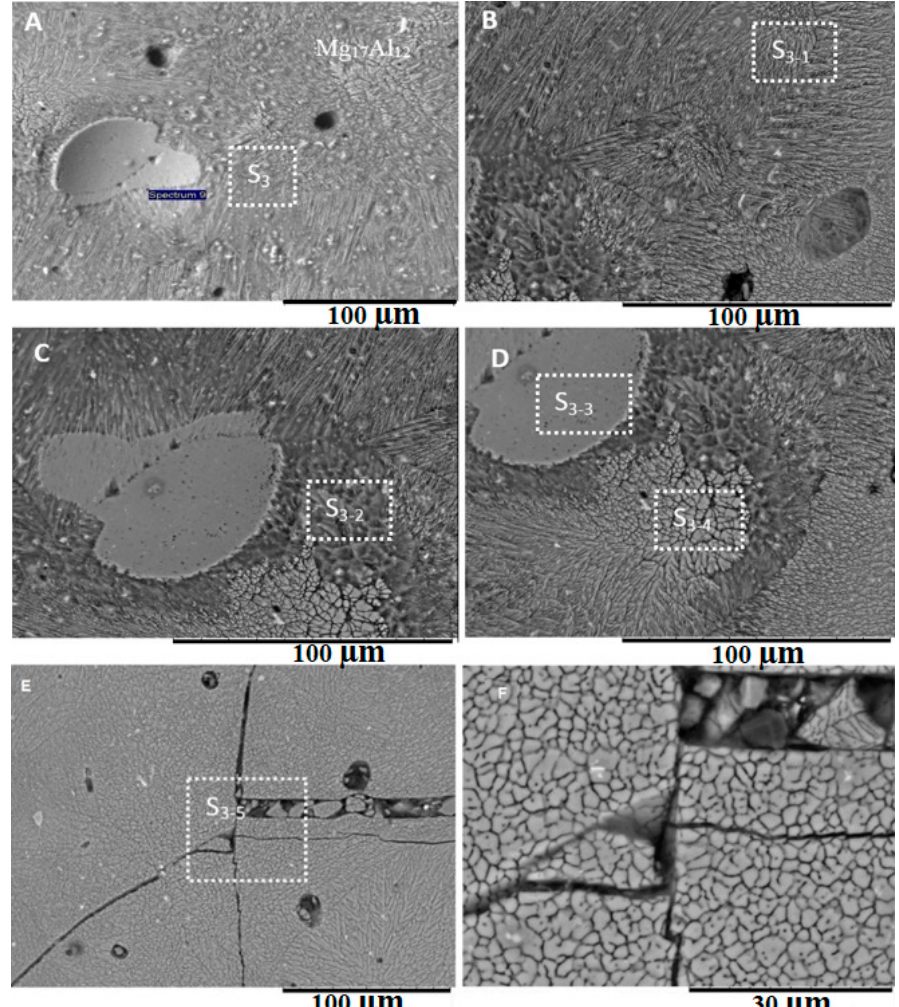
Figure 8. ( A ) Microstructures in the middle of the weld region labeled as S 3 ; ( B ) Columnar grains; ( C ) incomplete equiaxed grain transitions; ( D ) Columnar to equiaxed transition; ( E ) Equiaxed grains in the center of the weld; ( F ) Detailed view of the region labeled S 3-5 .